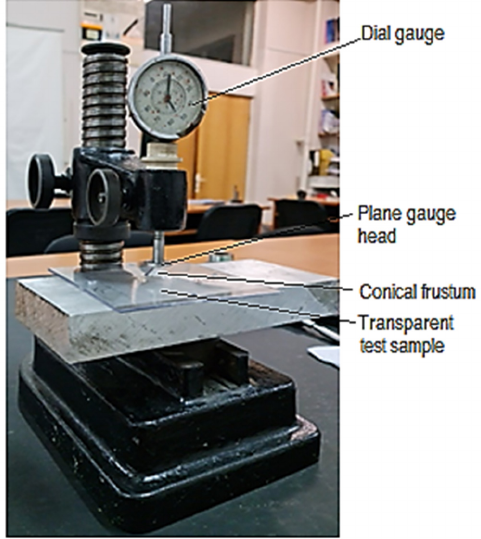
Figure 4. Setup used to measure the heights of the conical frustums.